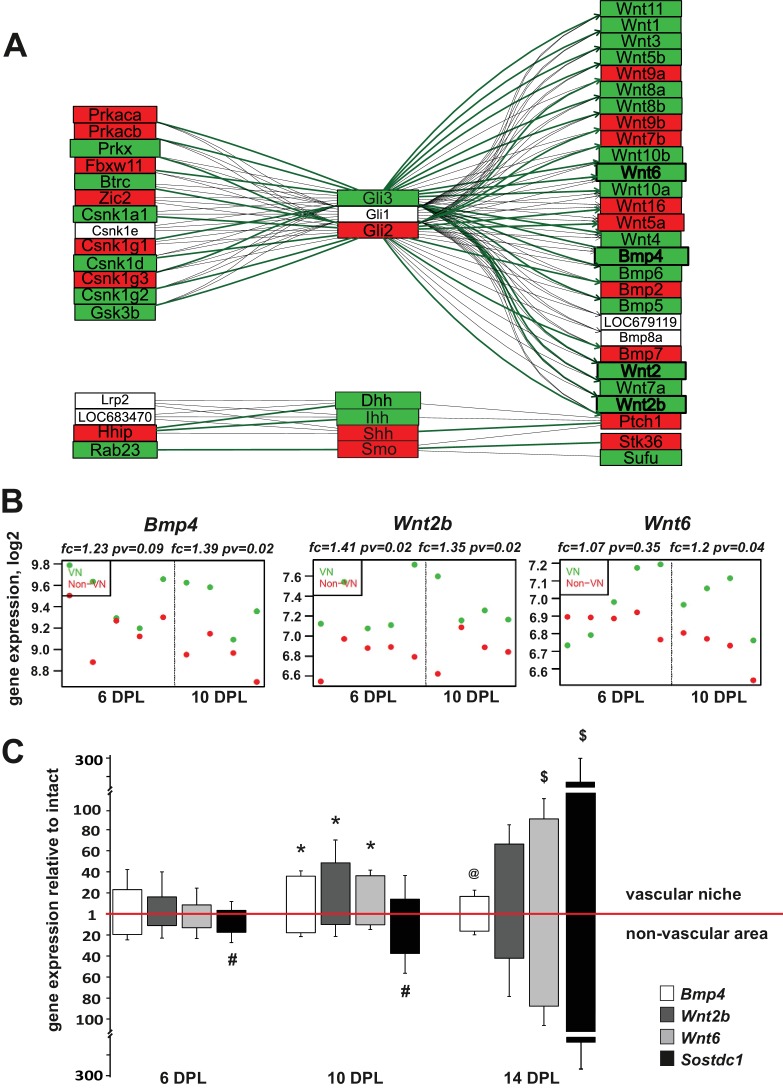
Injury-induced vascular niche is enriched with BMP and Wnt morphogen transcripts.(A) Graphical representation of BMP/WNT/Hedgehog signalling pathway interactions based on 10 dpl microarray results, higher expression of particular gene in non-VN in red, a higher expression in a VN group in green. Computed expression changes were marked over the existing topology using green-red colour scheme. Box size represents the relative difference of expression, genes with significant changes of expression bolded (Fisher’s exact test, adj.p < 0.05). In order to highlight observed differential co-regulation of gene expression, consistent relations were marked with green. Two genes were assumed to be in consistent relation if changes of their expression levels between the compared groups were consistent with type of regulations between them (activation or inhibition). Such consistent relations indicate functionally related expression changes (Mieczkowski et al., 2012). (B) Absolute expression of BMP4, Wnt2b, and Wnt6 in VN (green) and non-VN (red) at 6 and 10 dpl, dots represent expression level for each sample. (C) Relative gene expression (mean ± sd; n = 3, Mann-Whithney U-test, *p<0.001 compared with control levels of intact tissue as well as with non-VN at the same time point, # p<0.05 compared with control levels of intact, @p<0.01 compared with BMP4 level at 10 dpl, $p<0.001 compared with control levels of intact tissue as well as with 6 dpl and 10 dpl).